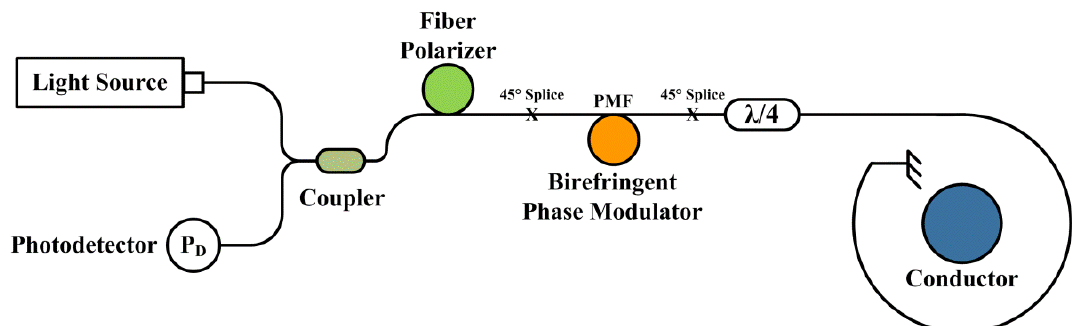
Figure 6 . In-line interferometer current